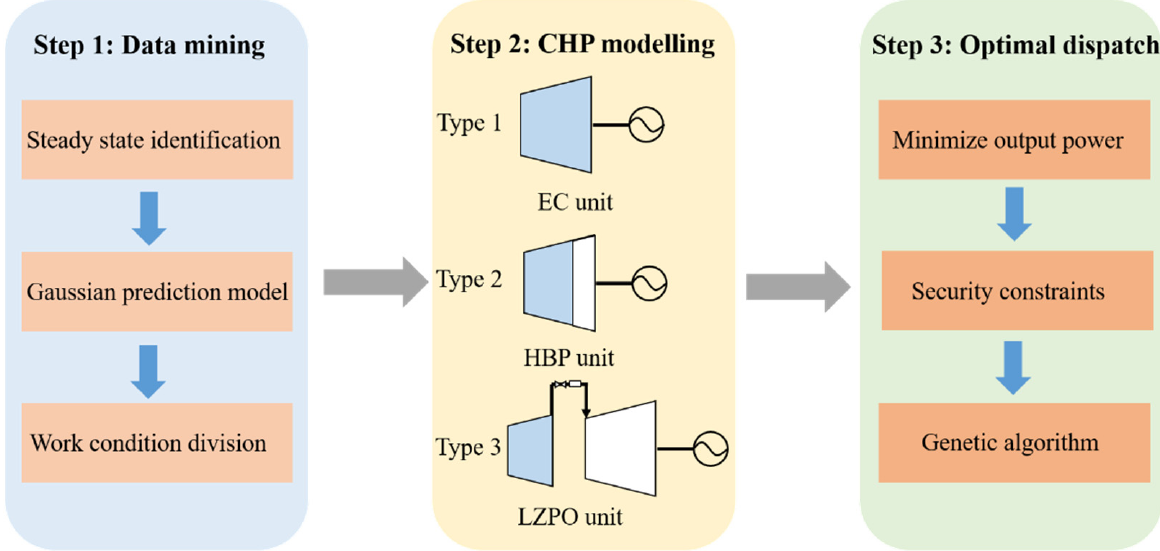
Figure 2. Standard solution procedure for dispatching multi-CHP units .